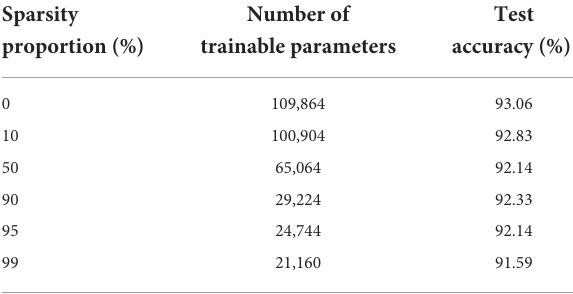
TABLE 9 Results on the SHD dataset for a non-recurrent adLIF network of size 3 × 128, with a sparser connectivity in the first layer.